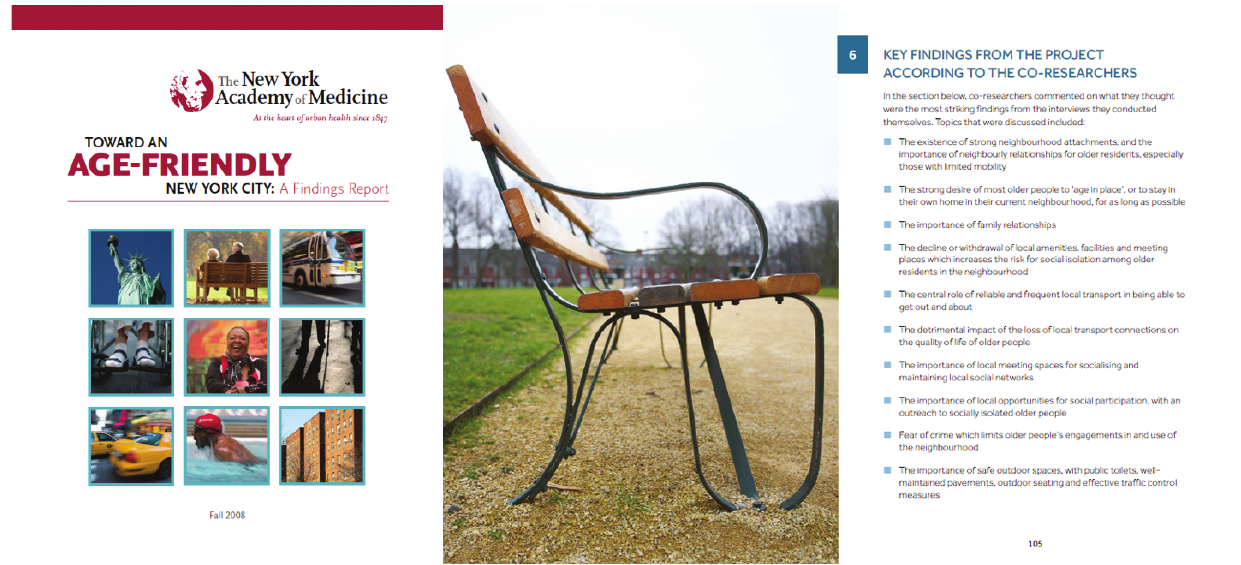
Figure 5. Cover of a New York city report supporting NYC AFCC (left; Finkelstein et al., 2008); inside pages of Manchester AFCC (right; Buffel, 2015).